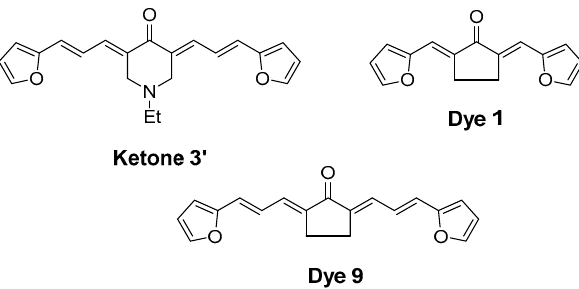
Figure 8. Chemical structures of ketone 3 ′ , dye 1, and dye 9.